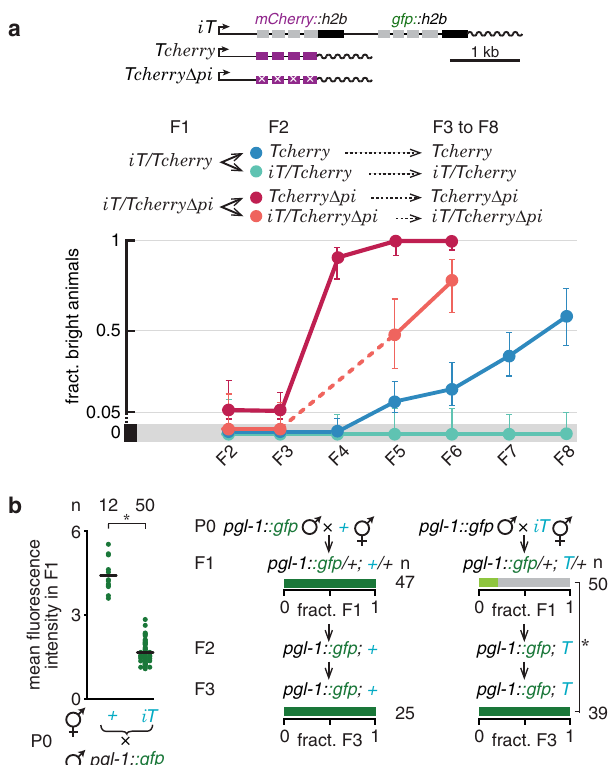
Fig. 5 Trans silencing within the germline can be followed by recovery of gene expression and resistance to subsequent silencing within a few generations. a Tcherry or Tcherry Δ pi animals were mated with iT stably silenced for >150 generations and fractions of animals with bright Tcherry or Tcherry Δ pi expression were scored in resulting cross progeny (F1) and their descendants (F2 through ≤ F8). Error bars indicate 95% con fi dence intervals. Schematics of transgenes used are indicated above the graphs. See Supplementary Fig. 7j, k for number of animals analyzed in each generation for each genotype and for pedigree. Fractions of bright animals are plotted and error bars indicate 95% CI. b pgl-1::gfp animals were mated with non-transgenic or iT animals and fl uorescence of PGL-1::GFP was quanti fi ed in cross progeny (left) or scored as in Fig. 1c in cross progeny and their descendants (middle and right). Chromosomes with a recessive dpy marker (blue font) and number of animals scored ( n ) are indicated. Also see Supplementary Fig. 7. Asterisks indicate P < 0.05 using two-tailed Student ’ s t -test (b, left) or χ 2 test ( b , right). Source data are provided as a Source Data fi